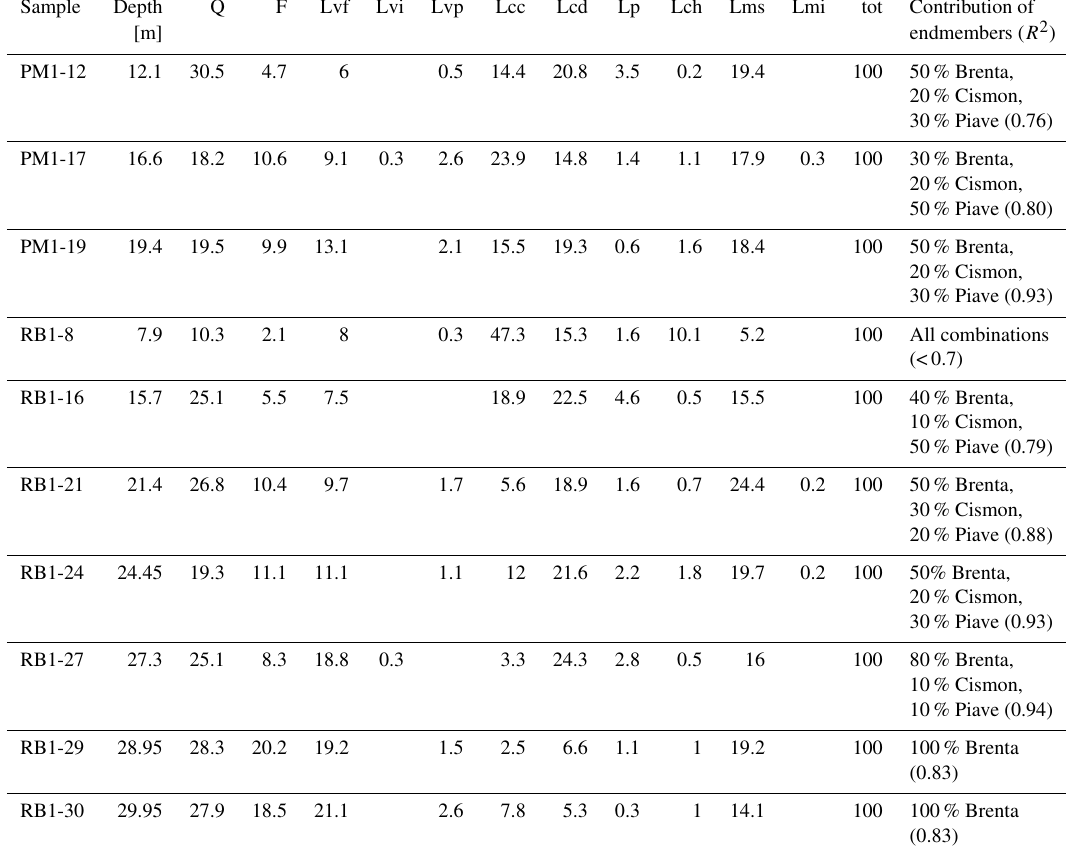
Table 2. Detrital modes of the sand fraction collected on RB1 and PM1 cores. List of acronyms: Q represents quartz; F represents feldspars; Lvf represents felsic volcanic and sub-volcanic lithic fragments; Lvi represents intermediate and mafic lithic fragments; Lvp represents plutonic lithic fragments; Lcc represents limestone grains; Lcd represents dolostone grains; Lp represents shale and siltstone lithic fragments; Lch represents chert grains; Lms represents low-grade metamorphic lithic fragments; and Lmi represents medium-grade metamorphic lithic